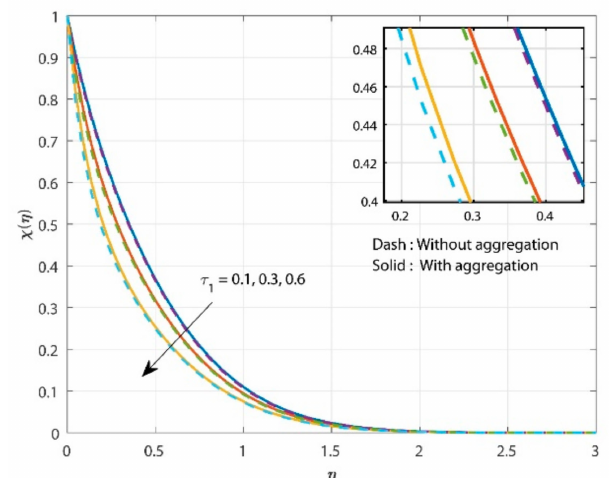
Figure 8. Influence of thermophoretic parameter on χ